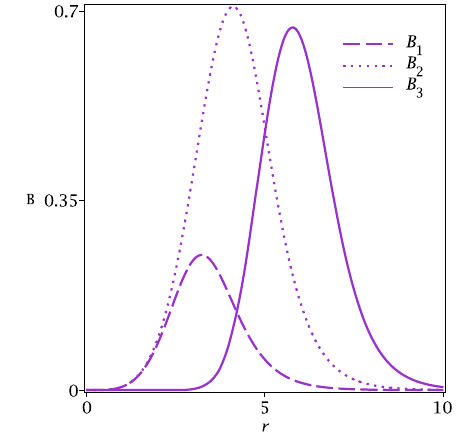
Fig. 7 Magnetic inductions from sectors 1, 2 and 3, with n 1 = 2, n 2 = 8, n 3 = 10 and permeabilities given by (28)